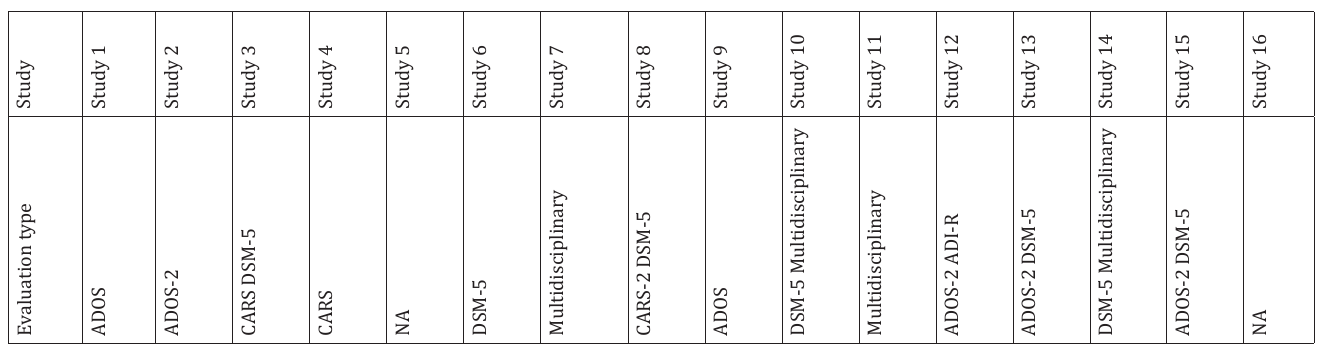
Diagnostic methods used in studies